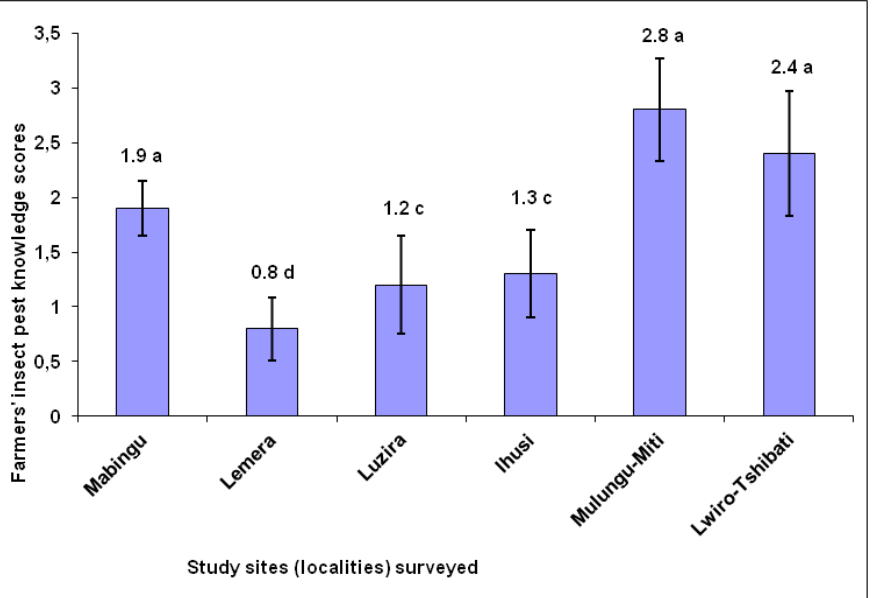
Figure 3: Farmers’ knowledge about insect pests of potato in six study sites of South-Kivu province (eastern DRCongo; 2016 surveys) Scores: 0 = no knowledge, 1 = low knowledge, 2 = medium knowledge, 3 = high knowledge. Bars with the same letter are not statistically different at P ≤